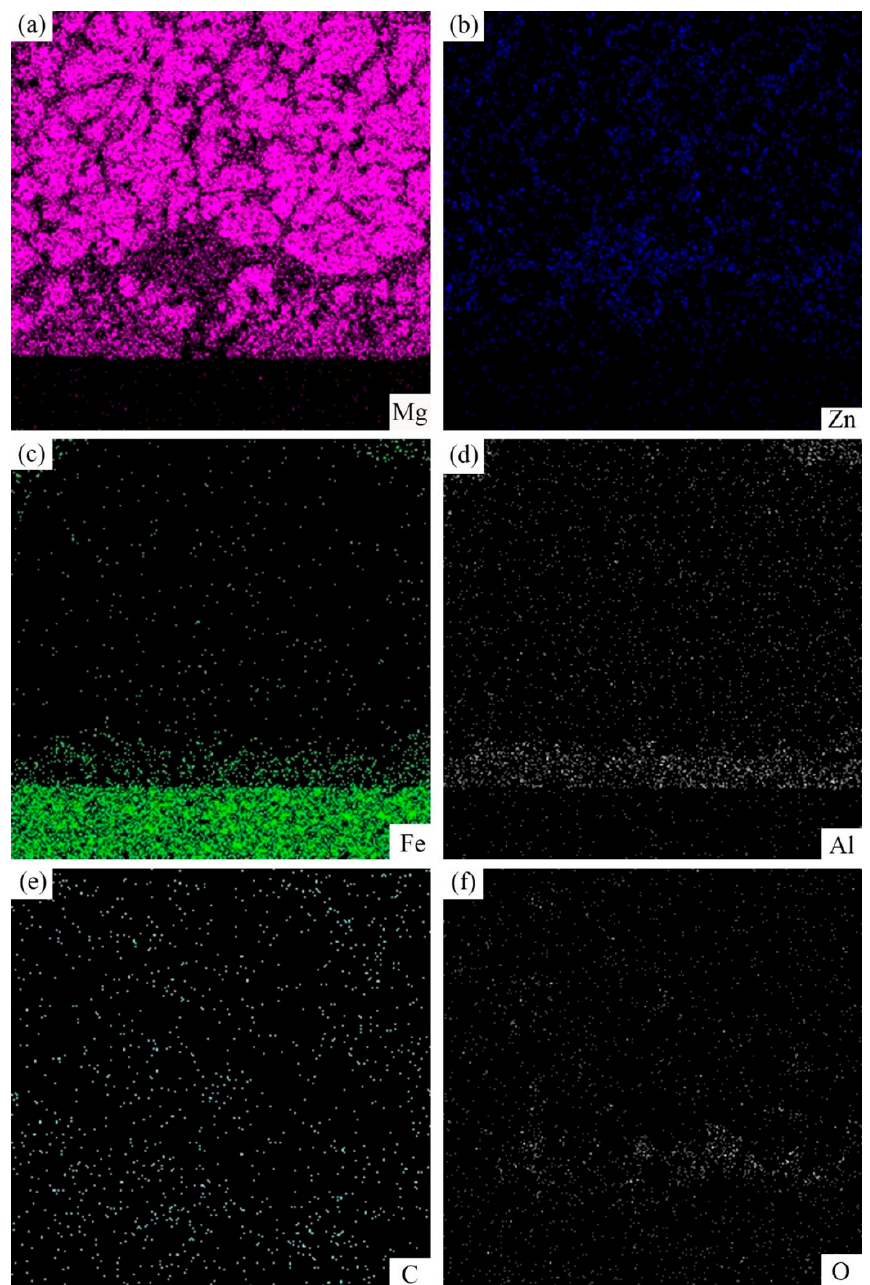
Figure 5. ( a ) SEM micrograph of interface in galvanized-steel/AZ91D; ( b ) EDS line scan of galvanized- steel/AZ91D interface marked in (a).